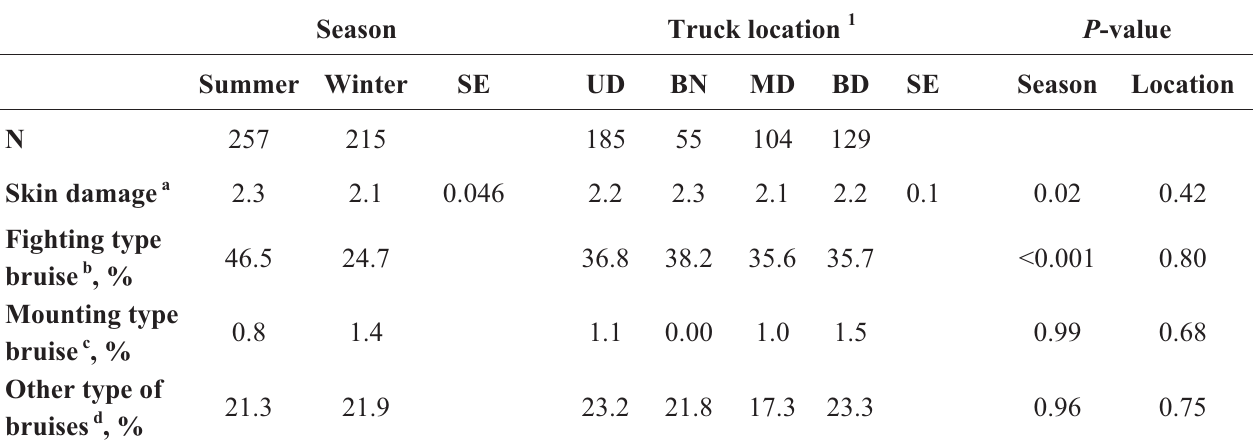
Table 4. Skin damage score and percentage of bruised carcasses of pigs transported on the PB trailer according to the season and the truck